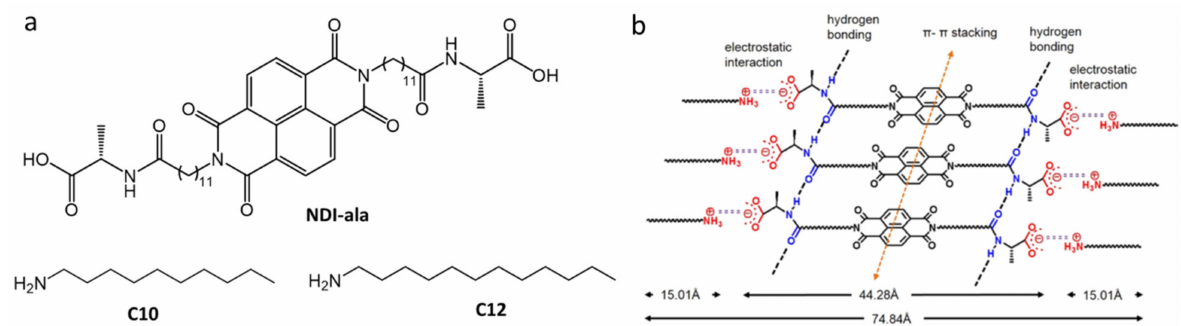
Figure 20. ( a ) Molecular structures of NDI-ala and amines, n -decylamine (C10) or n -dodecylamine (C12). ( b ) Tentative model (based on data from Fourier transform infrared (FTIR), PXRD, and SAXS) for the molecular packing arrangement of the two-component co-assembled system, NDI-ala12. The molecular length of C12 in its extended conformation was used to estimate the total length of NDI-ala12. Reprinted (adapted) with permission from [84]. Copyright (2016) American Chemical Society.